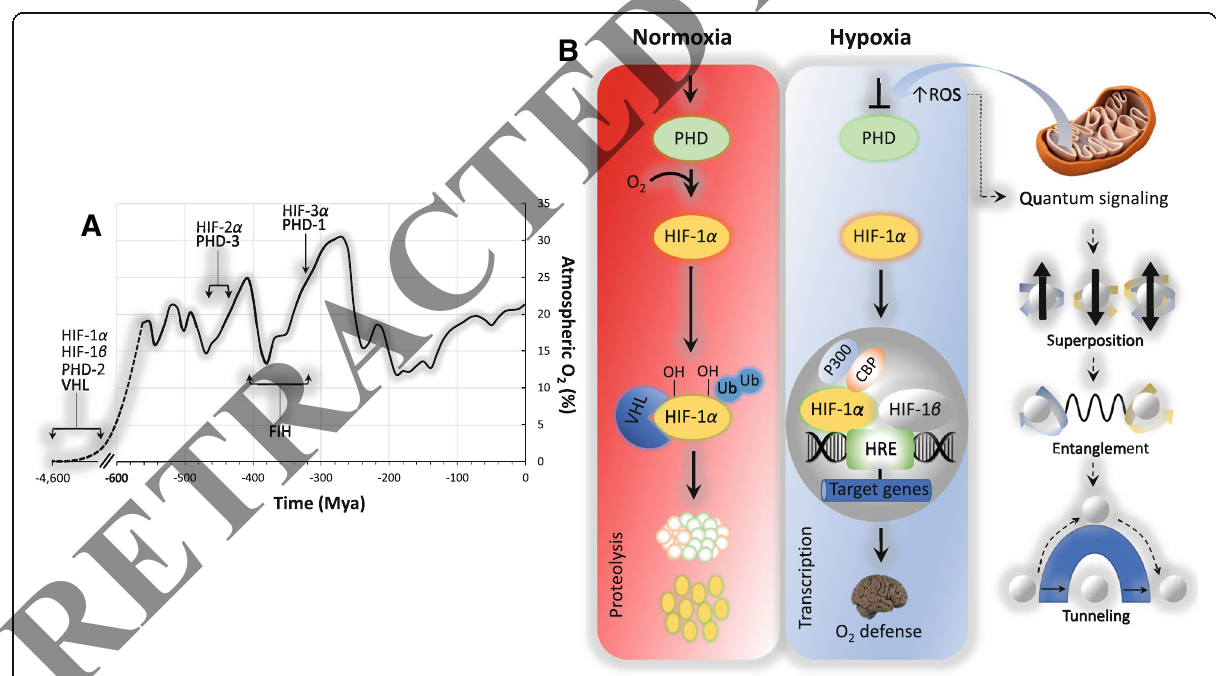
Fig. 4 a Evolution of genes encoding the hypoxia-inducible factor (HIF) pathway and ( b ). Importance of mitochondrial-generated reactive oxygen species (ROS) stabilization of HIF-1 α during hypoxia including emergent quantum signaling aspects. a Appearance of genes based on published approximations (Taylor and McElwain 2010). b During normoxia, hypoxia-inducible factor-1 alpha (HIF-1 α ) is hydroxylated on prolines by the prolyl hydroxylases (PHD), tagging it for recognition by the von Hippel Lindau tumor suppressor protein (VHL) resulting in the continual ubiquitination and degradation of HIF-1 α . During hypoxia, the mitochondrial formation of the superoxide anion from the Qo site of the bc1 complex of Complex III are released into the intermembrane space and enter the cytosol to decrease PHD activity preventing hydroxylation resulting in HIF-1 α stabilization and transcription of genes that collectively preserve cerebral oxygen (O 2 ) homeostasis. Note that emerging “ quantum ” aspects of cerebral O 2 sensing are also outlined. FIH, factor inhibiting HIF; CBP, cyclic AMP-response element binding protein; HRE, hypoxia response